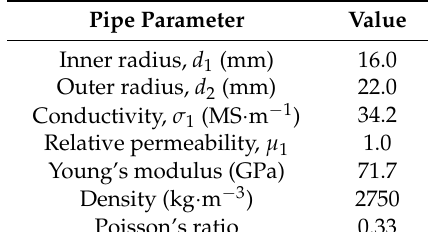
Table 2. Parameters of the nonmagnetic pipe.